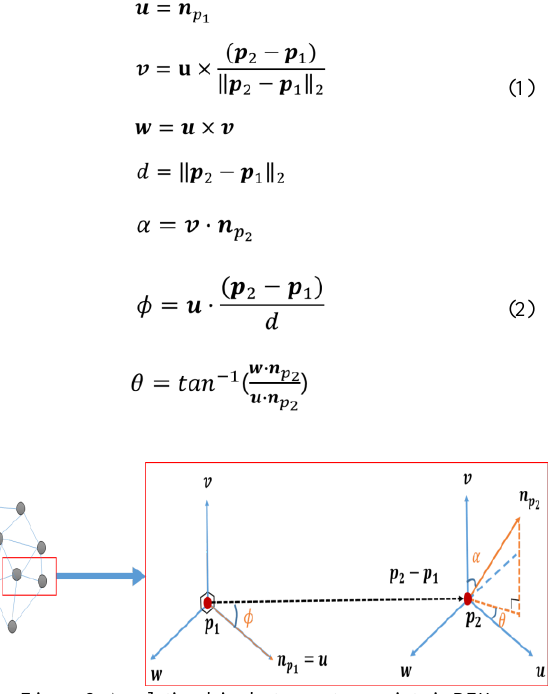
Figure 3. A relationships between two points in